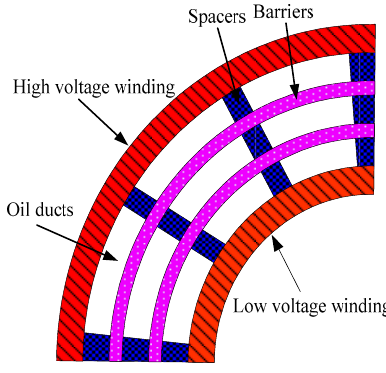
Figure 7. Cross-section diagram of the transformer main insulation system.